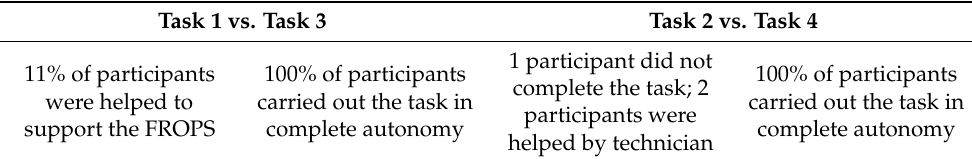
Table 5. Effectiveness evaluation for the four tasks